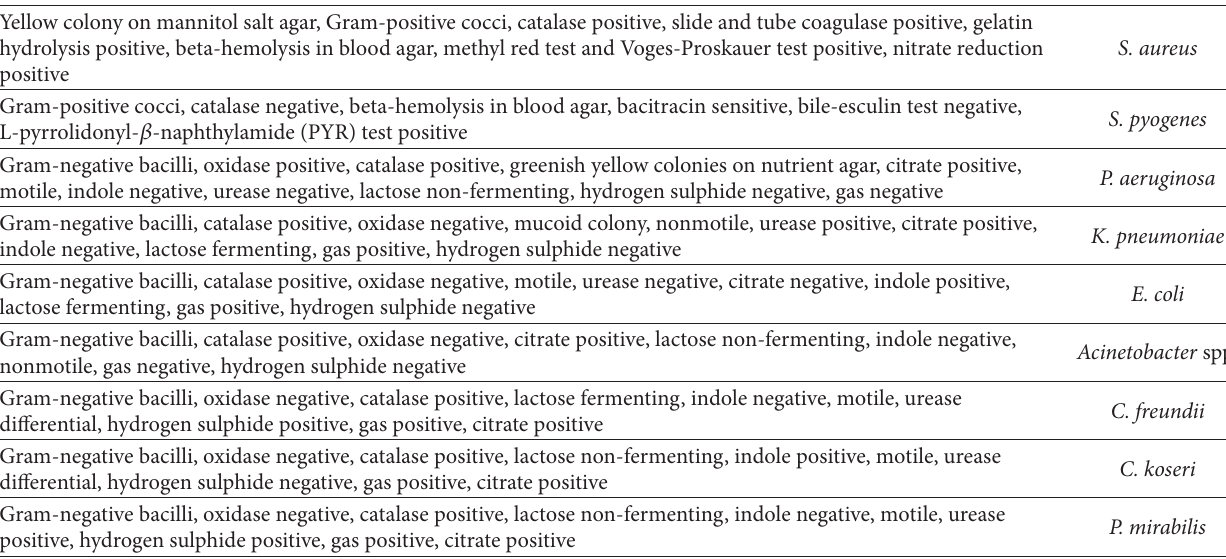
Table 1: Results of biochemical tests of different bacteria isolated in our study.